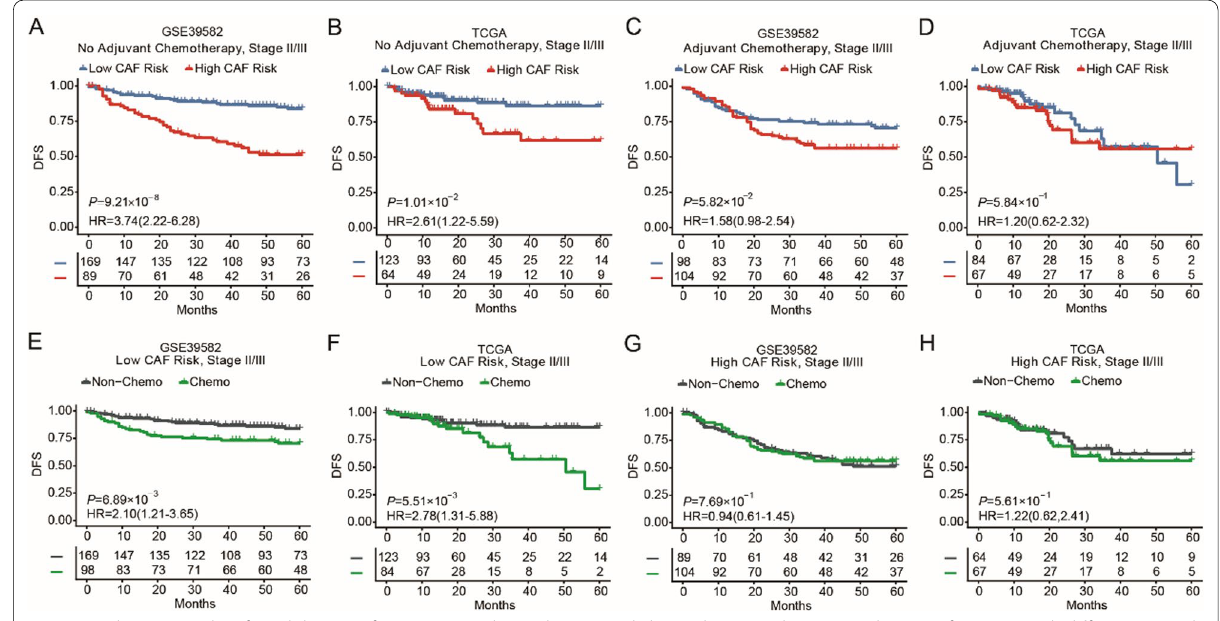
Fig. 3 Kaplan–Meier plots for validations of FRGS in non‑chemotherapy and chemotherapy cohorts. A , B The DFS of patients with different CAF risk group in stage II/III patients without adjuvant chemotherapy: GSE39582 cohort ( A ) and TCGA cohort ( B ). C , D The DFS of patients with different CAF risk group in stage II/III patients with adjuvant chemotherapy: GSE39582 cohort ( C ) and TCGA cohort ( D ). E , F The DFS of patients with or without adjuvant chemotherapy in stage II/III patients with low CAF risk: GSE39582 cohort ( E ) and TCGA cohort ( F ). G , H The DFS of patients with or without adjuvant chemotherapy in stage II/III patients with high CAF risk: GSE39582 cohort ( G ) and TCGA cohort ( H